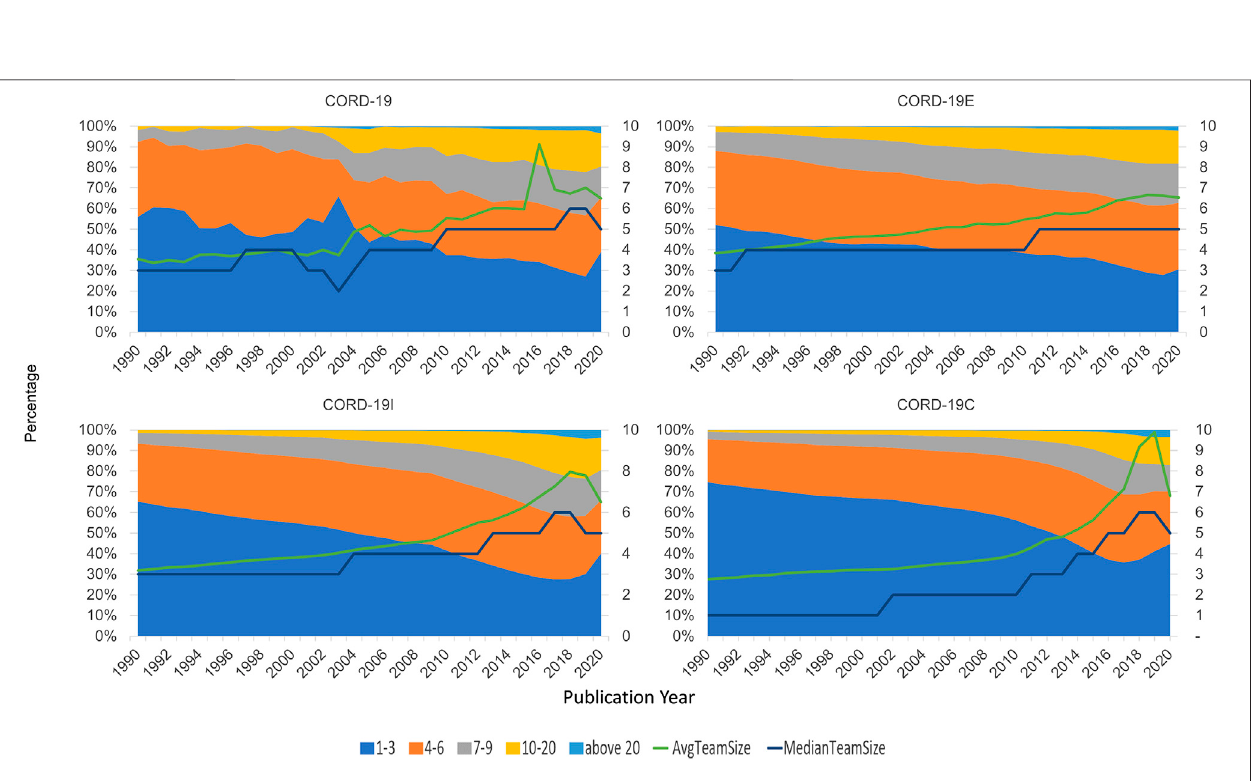
FIGURE 11 | Team size distribution of authoring teams, by year, across COVID-19 Research Dataset (CORD-19) and its three closure graph expansions.